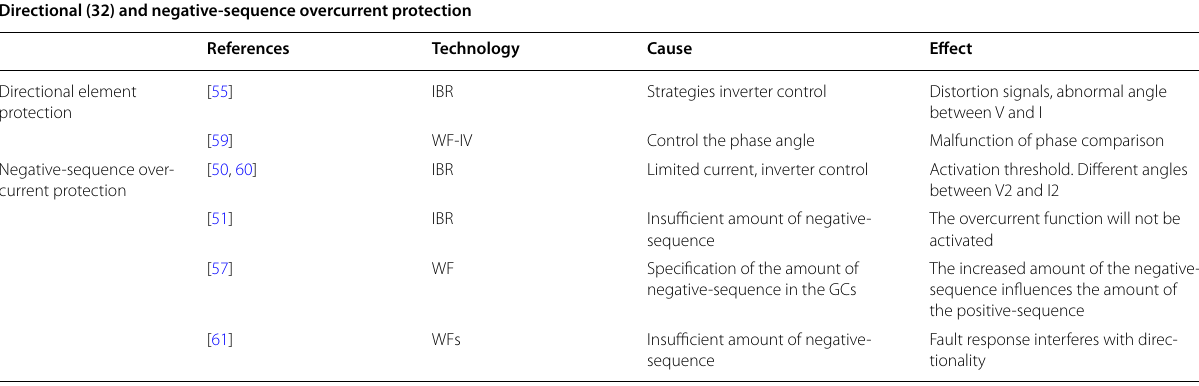
Table 8 Causes and effects on directional and negative-sequence overcurrent protection due to IBR Directional (32) and negative-sequence overcurrent